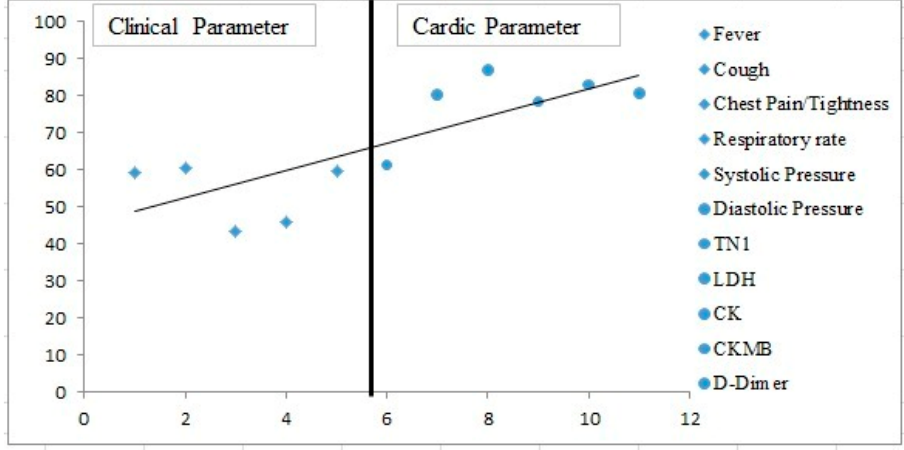
The death to live/discharge ratio among the abnormal cardiac biomarker associated COVID-19 patients were 91.4:8.6% or 457:43. Most of the deaths were observed in patients with older age ( p < 0.001), rate of respiration ( p =0.001), myocardial injury patients ( p < 0.001), patients with comorbidities ( p = 0.003), levels of urea nitrogen ( p = 0.001), direct bilirubin ( p = 0.049) and total bilirubin ( p = 0.030), AST ( p = 0.009), ALP ( p = 0.004), SAA ( p = 0.034), ESR ( p = 0.017), procalcitonin ( p = 0.017), CRP ( p = 0.001), LDH ( p = 0.001), CK ( p = 0.003), TNI levels ( p = 0.014), platelets ( p = 0.001), neutrophils ( p = 0.001), white blood cells ( p = 0.001) and IL-6 ( p = 0.004) as shown in (Table 3).